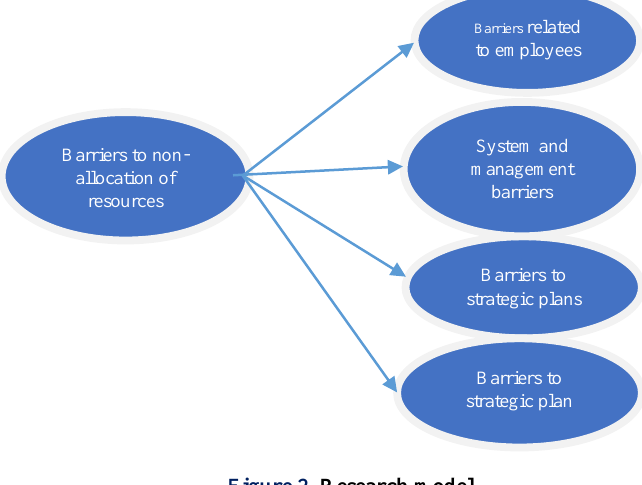
Figure 2 . Research model